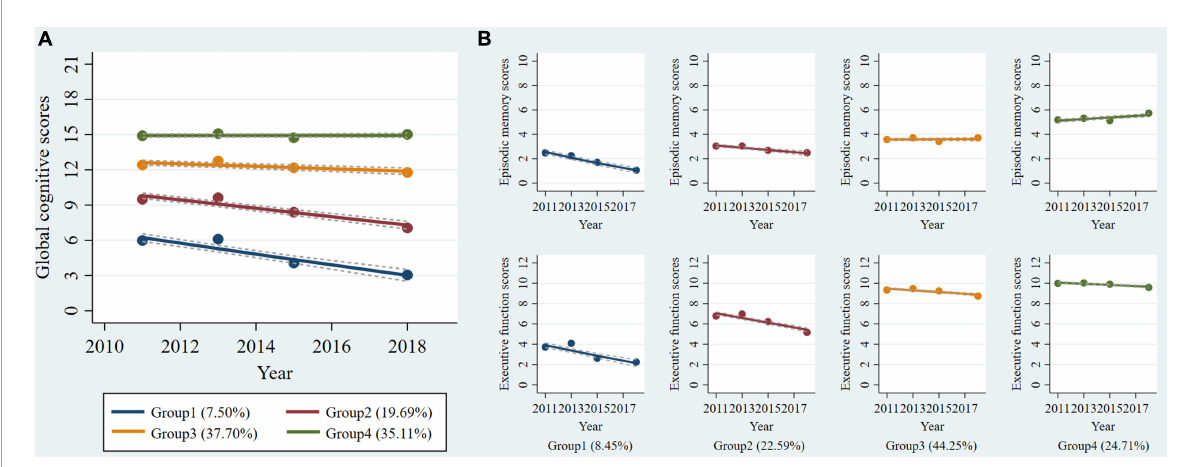
FIGURE1 Trajectories of cognitive function from 2011 to 2018 among non-normotensive populations. Graphs show four trajectories of global cognitive function (A) and four multi-trajectories of executive function and episodic memory (B) . Descriptions of the trajectory groups are as follow: (A) group 1: “low-declining,” group 2: “moderate low-declining,” group 3: “moderate high-stable,” group 4: “high-stable”; (B) group 1: “episodic memory: low-rapid declining + executive function: low-declining,” group 2: “episodic memory: low- minimal declining + executive function: moderate-declining,” group 3: “episodic memory: moderate-stable + executive function: high-declining,” group 4: “episodic memory: high–rising + executive function: